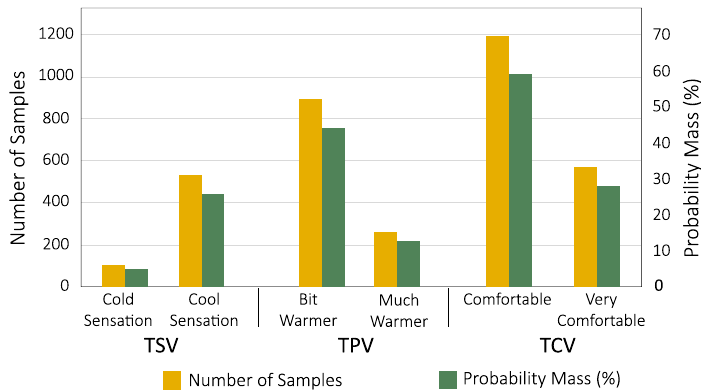
Figure 8. Illogical votes in student data.